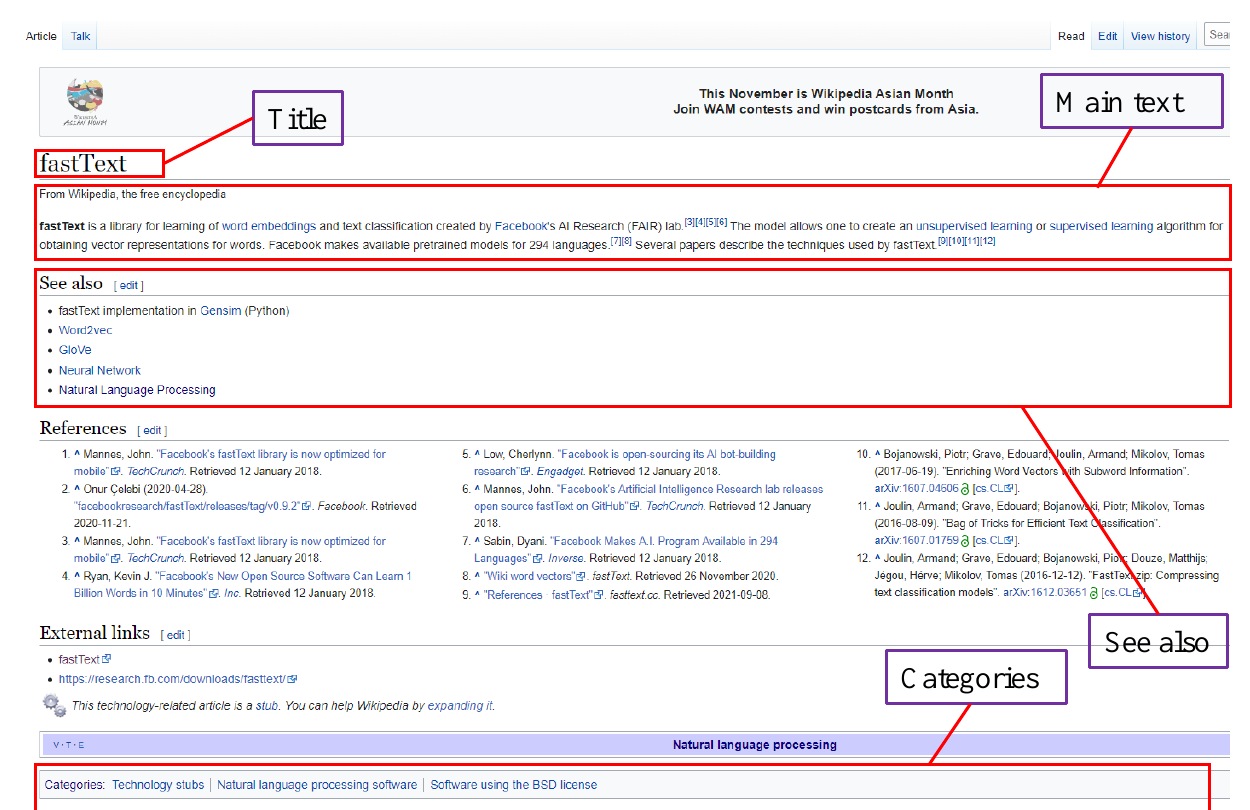
Figure 1. An example page in